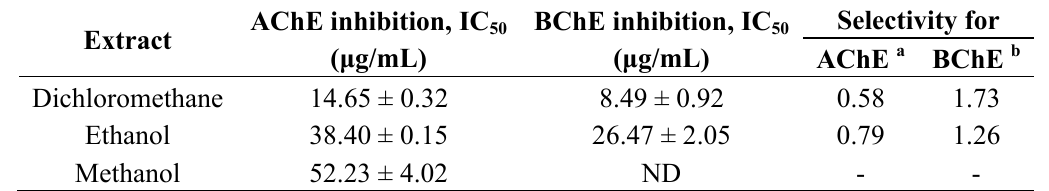
Table 1. IC values of Rauvolfia reflexa extracts for inhibitory activities on cholinesterase enzymes. 50